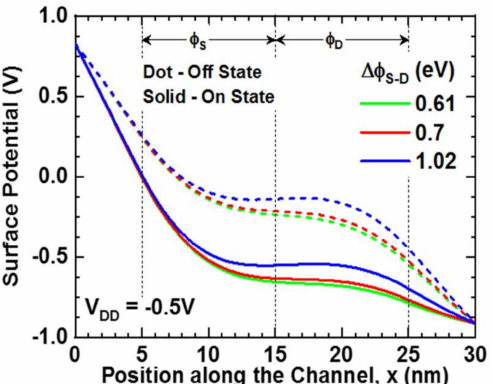
Figure 5. Surface Potential along the channel—dot line: off-state (V DD = − 0.5 V, V GS = 0 V), solid line: on-state (V DD = V GS = − 0.5